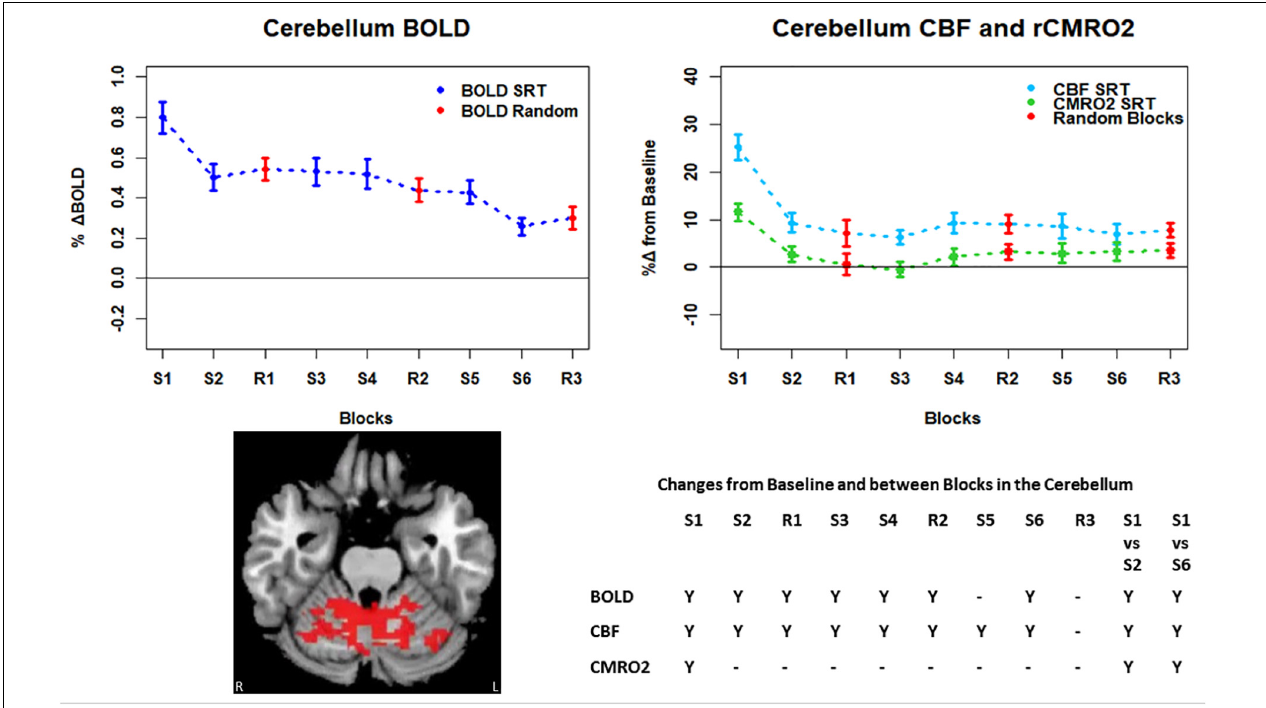
FIGURE 7 | Mean ± SEM SRT task responses in the cerebellum. Plots show a mean reduction in BOLD and CBF across task blocks. S1 = SRT block 1, R1 = random block 1. Y = Yes to indicate statistically significant ( p < 0.05), signal changes from baseline and between first and second and first and last SRT blocks. BOLD and CBF showed significant increases from baseline across all sequence and pseudorandom task blocks, except S5 and R3 for BOLD, and R3 for CBF. There were also significant reductions in BOLD and CBF between sequence blocks S1 and S2 and S1 and S6. CMRO 2 increases from baseline were only detected in the first sequence blocks and there were significant reductions from S1 in S2, and